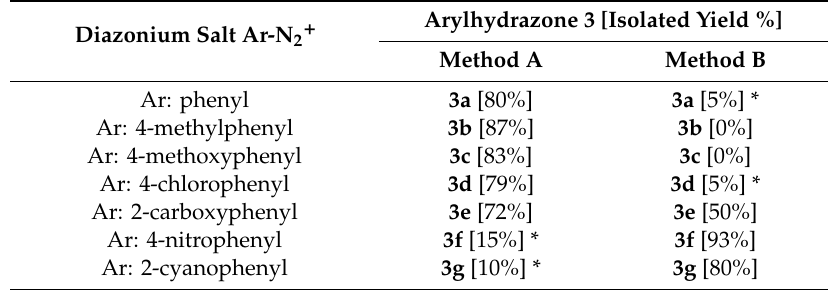
* yield based on HPLC analysis.